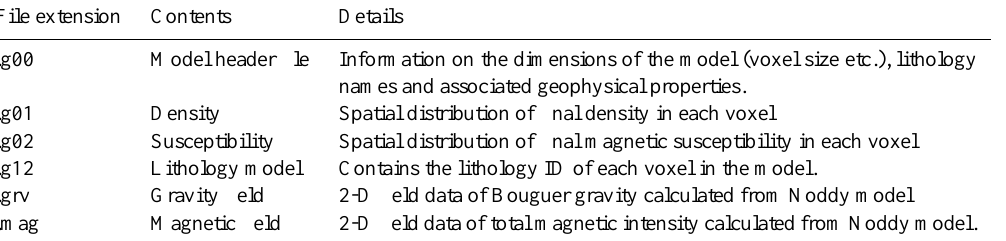
Table 1. Descriptions of the output files produced by the command line version of Noddy. Files for calculated potential fields are calculated when Noddy is called in Geophysics mode (see Sect.